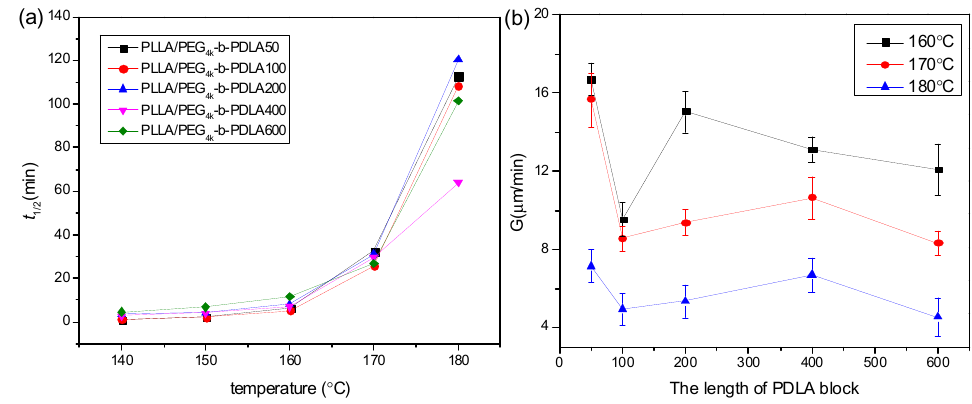
Figure 8. ( a ) Crystallization half-time ( t 1/2 ) and ( b ) radial growth rate of spherulites ( G ) of PLLA/PDLA-PEG 4k -PDLA with different PDLA blocks isothermally crystallized at different temperatures.